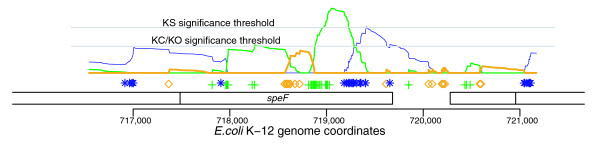
Random walk plots for positive local scores in the vicinity of the speF gene. SpeF is a mosaic gene by virtue of its KS and KO clusters. Note the small cluster of KC SNDs appears to divide a large KS segment near coordinate 718,600. This short KC spike, though not statistically significant on a whole genome scale, would undoubtedly pass a single gene substitution distribution type test.